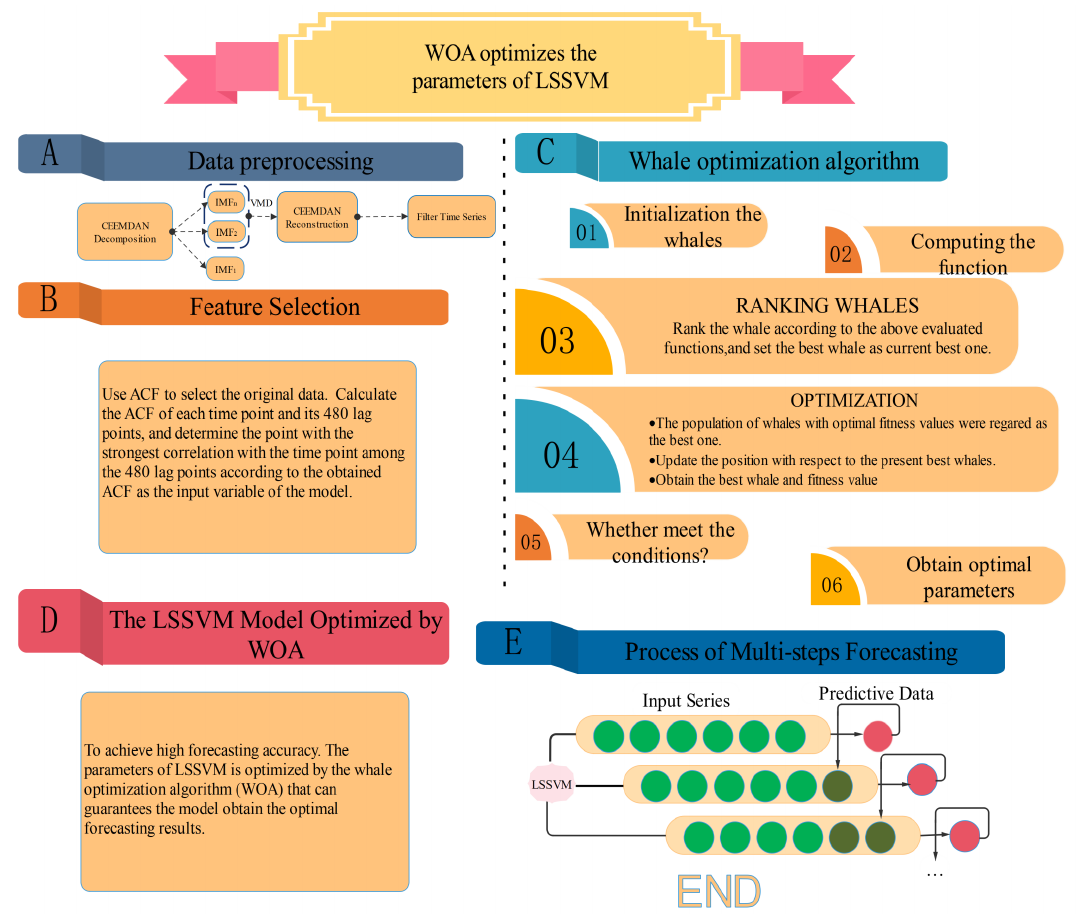
Figure 1. The flowchart and components of the proposed combined model to forecast PM 2.5 in the next